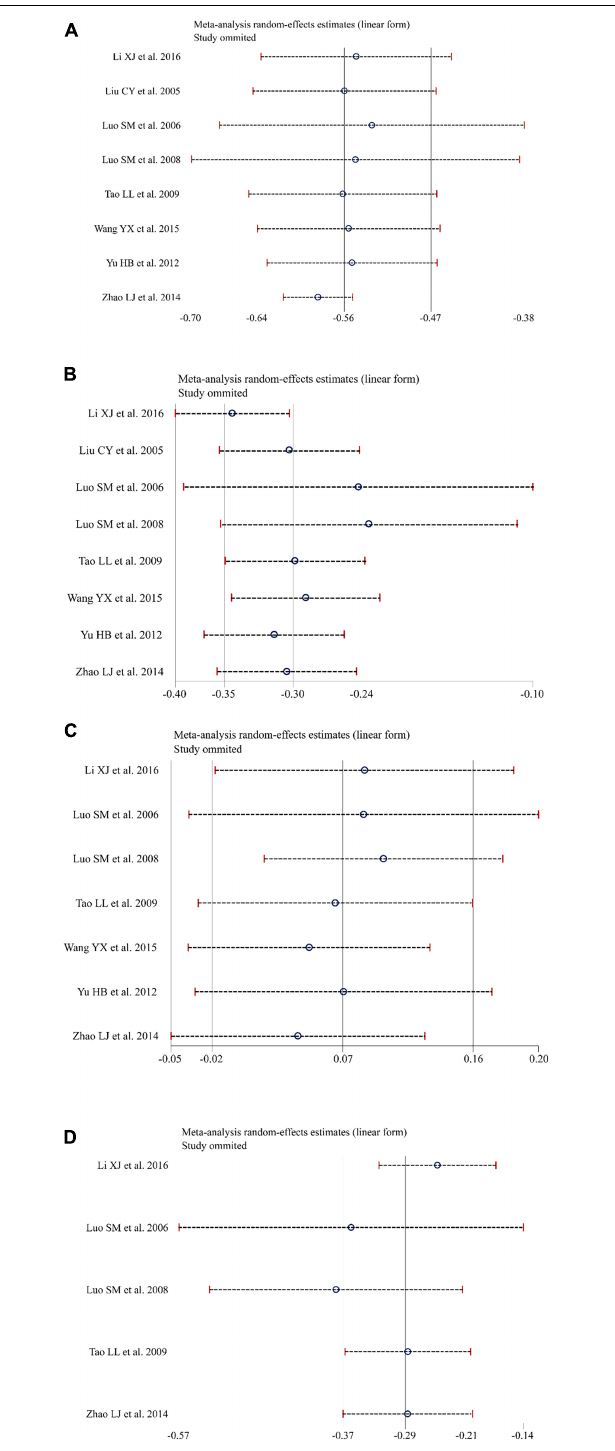
FIGURE 4 | Sensitivity analysis was conducted to determine the impact of each study on the overall effect size by using removing each study in turn. (A) Sensitivity analysis for total cholesterol (TC). (B) Sensitivity analysis for triglyceride (TG). (C) Sensitivity analysis for high-density lipoprotein cholesterol (HDL-C). (D) Sensitivity analysis for low-density lipoprotein cholesterol